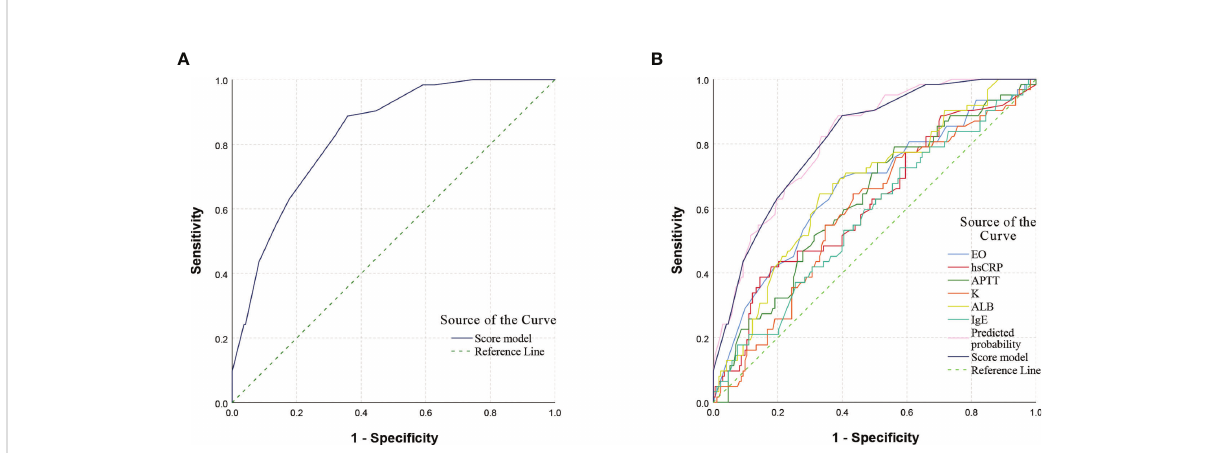
FIGURE 2 ROC curve of scoring model and single indicator. (A) ROC curve of the scoring model. The AUC (95% CI) for predicting GI bleeding was 0.832 (0.779, 0.884), P < 0.001. (B) ROC curve of the single indicator. A comparison of the AUC of the ROC curves for different indicators showed that the AUC of the scoring model was higher than that of the single indicator. The AUC (95% CI) for predicted probability was 0.833 (0.781, 0.885), P < 0.001, and the difference in AUC values between the scoring model and the predicted probability was not signi fi cant. ROC, receiver operating characteristic; AUC, area under the curve; CI, con fi dence